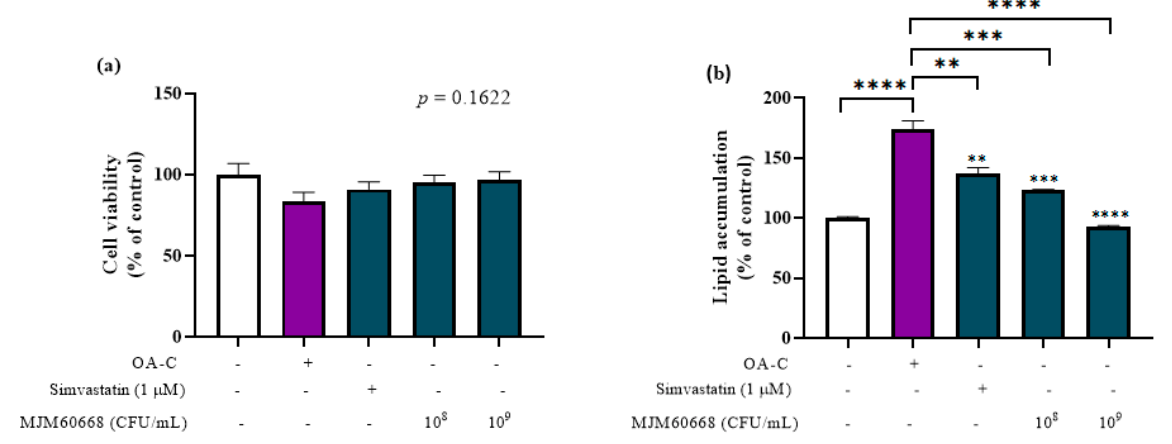
Figure 2. Effect of MJM60668 on HepG2 cells. HepG2 cells were stimulated with 1 nM Oleic acid and 7.5 µ g/mL Cholesterol (OA-C) and treated with MJM60668 for 6 h. Simvastatin (1 µ M) was used as a positive control. ( a ) Cell viability was measured by MTT assay. ( b ) Lipid accumulation on HepG2 cells was determined by the Oil Red O staining method. Results are presented as the mean ± standard deviation of triplicate independent experiments. ** p < 0.01, *** p < 0.001, **** p < 0.0001 compared with the OA-C treatment.